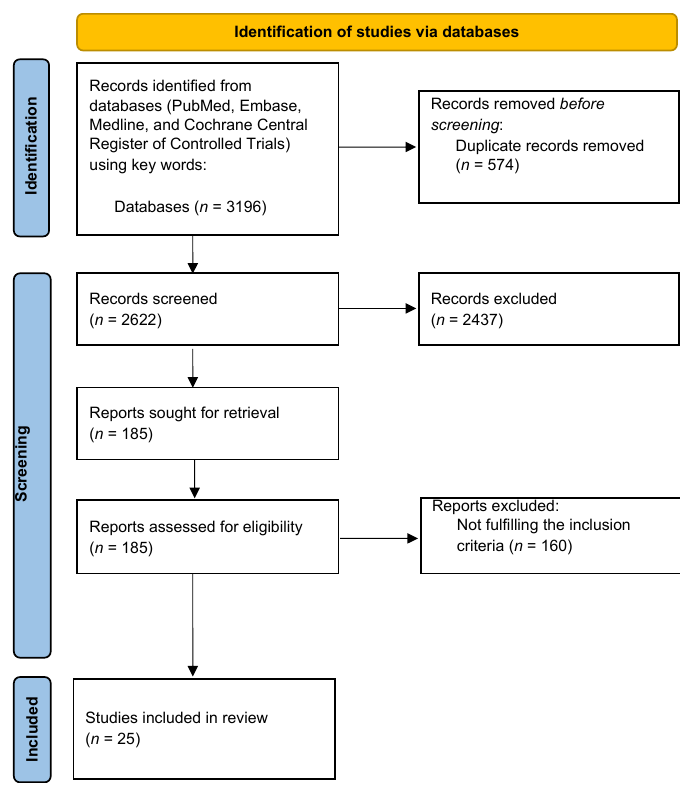
Figure 2. Flow chart of the search strategy using keywords (PRISMA diagram).